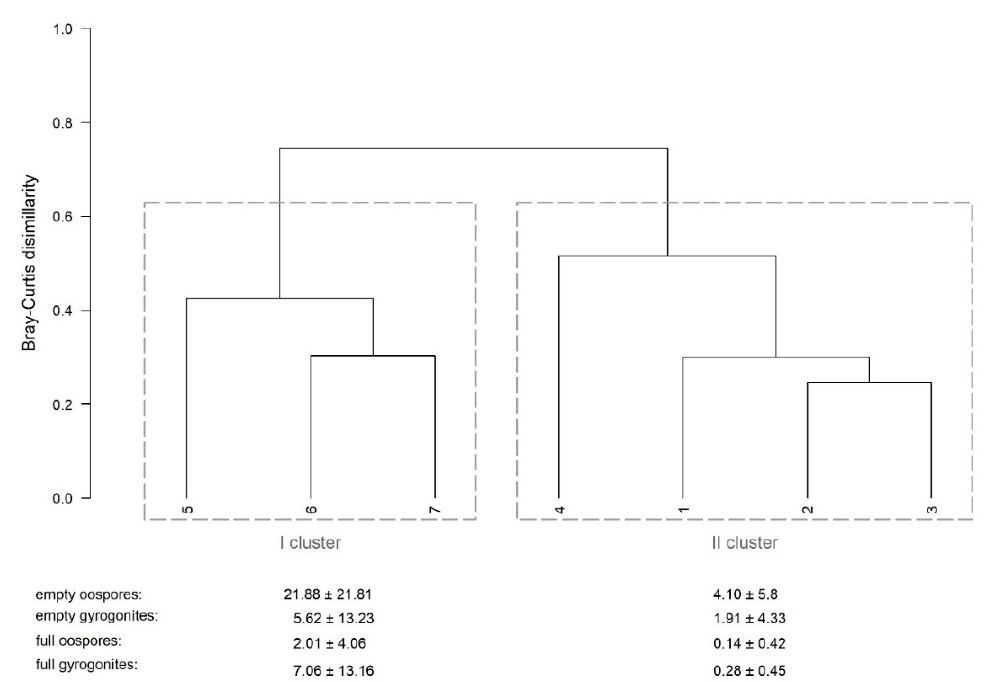
Figure 3. The dendrogram derived from the density of charophyte fructifications found in the seven profiles in the study area. The two main clusters (marked with Roman numerals) of the profiles (marked with Arabic numerals), indicated by dashed lines, and the mean ( ± standard deviation) density (10 3 ind. m − 2 ) of empty and full fructifications are provided below.